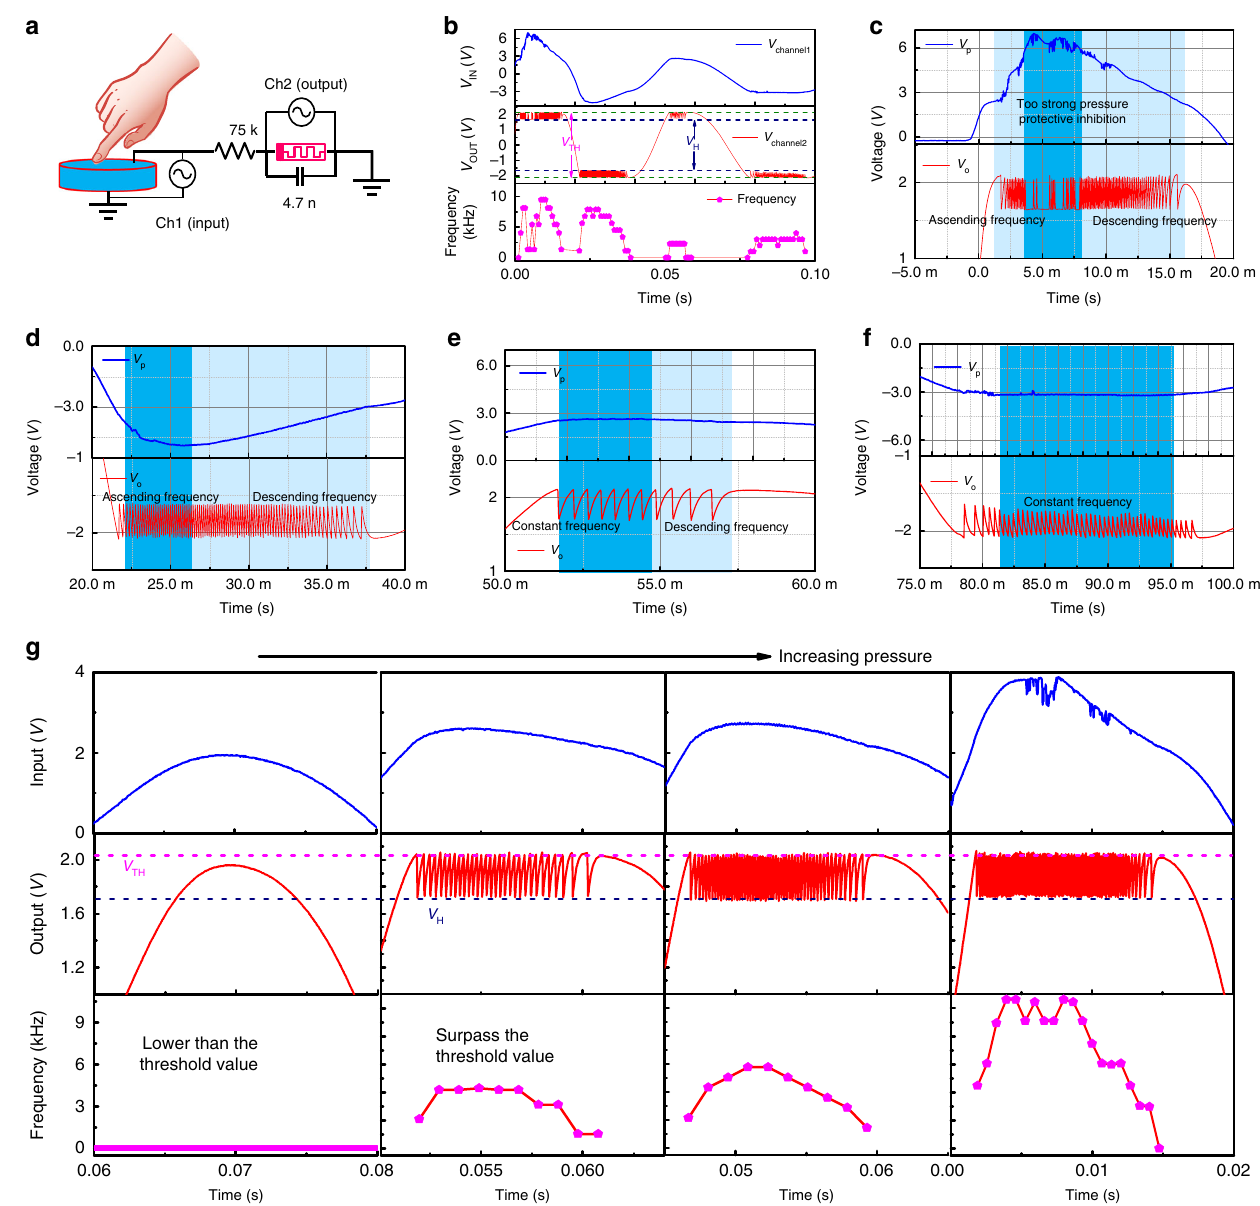
Fig. 5 Illustration of the arti fi cial spiking mechanoreceptor system (ASMS). a Schematic of the ASMS. A piezoelectric device is used as the tactile sensor and connected with the arti fi cial spiking afferent nerve. The voltage generated by the piezoelectric device serves as the input signal. b The experimental data of the ASMS. c – f A closer view of b , the protective inhibition behavior can be observed in c . g The frequency response of the ASMS under different pressure